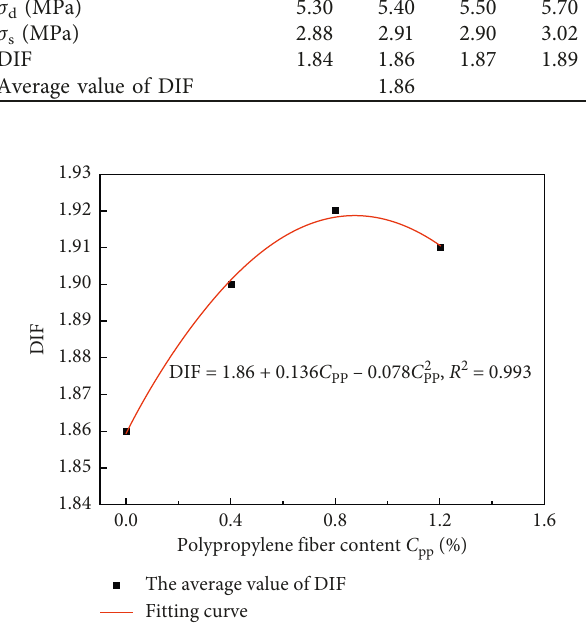
Table 4: DIF values of cement soil with different polypropylene fiber contents. Polypropylene fiber content